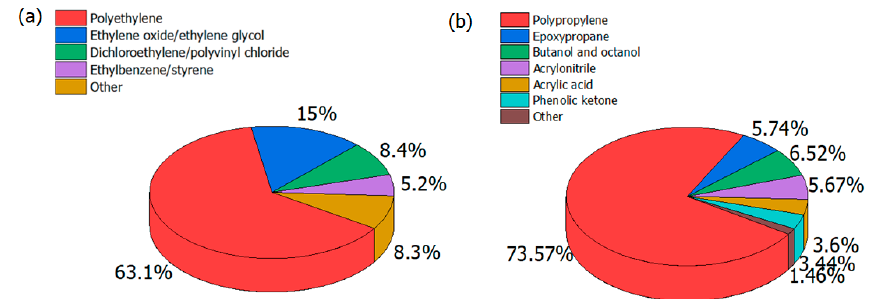
Figure 1. Downstream product consumption of ethylene ( a ) and propylene ( b ) [1,2].